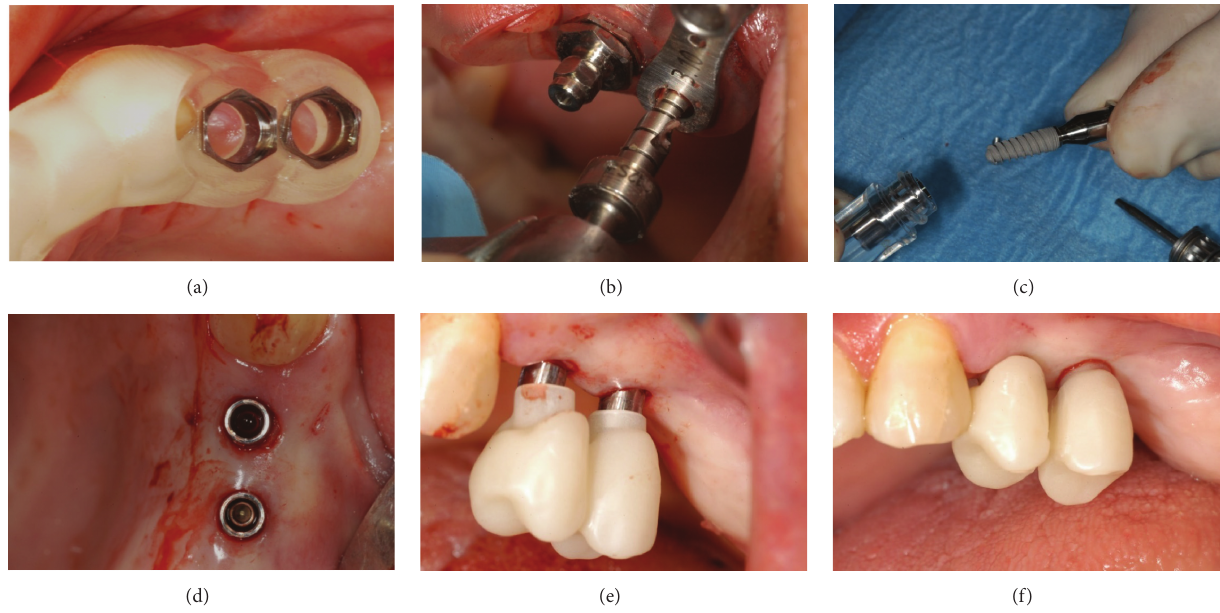
Figure 3: Surgery and immediate provisionalization: (a) the surgical guide in position; (b) preparation of the surgical sites; (c) implant placement; (d) all implants are placed with a flapless procedure; (e) the provisional PMMA restoration is placed on the temporary titanium abutments; (f) the provisional PMMA is screwed on the implants.